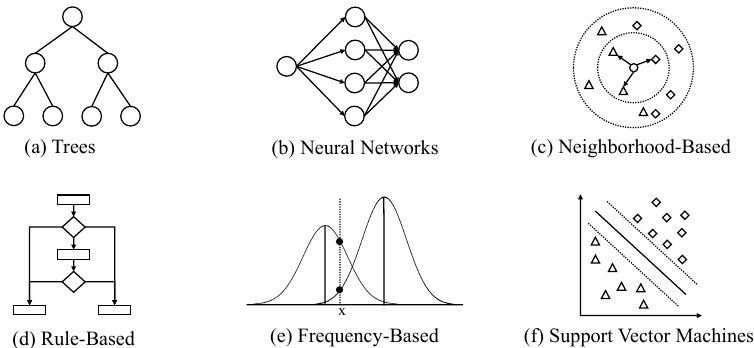
Figure 7. Overview of the most common algorithm types used in the reviewed literature in a stream classification scenario. The point shapes in ( c ) and ( f ) represent data of different